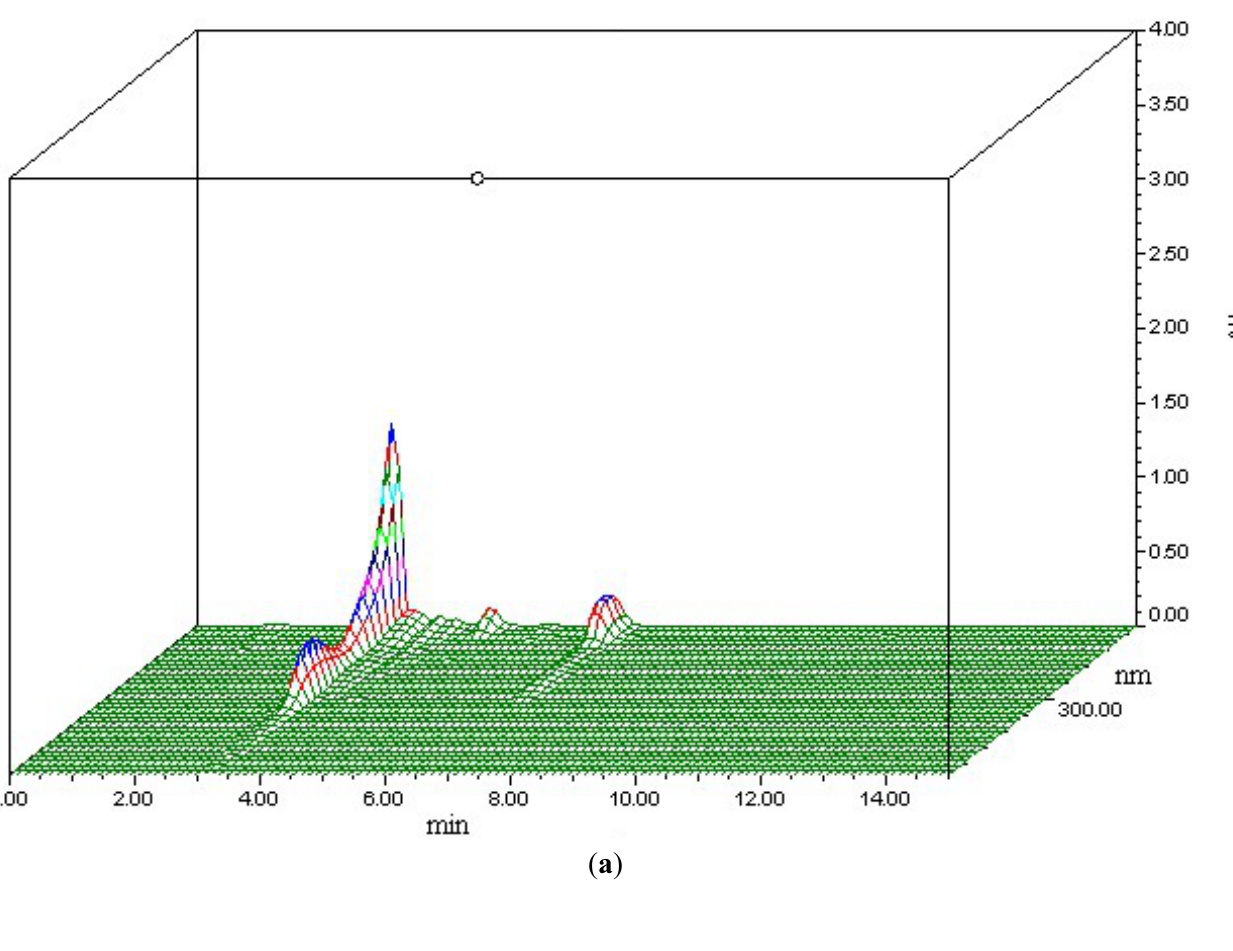
Figure 2. Representative chromatograms of: ( a ) a blank rat plasma sample; ( b ) a blank rat plasma spiked with salidroside and p- tyrosol (20 μ g/mL); ( c ) a rat plasma sample collected 5 min after i.v. administration of salidroside (50 mg/kg); ( d ) a rat plasma sample collected 30 min after i.g. administration of salidroside (100 mg/kg). (1: salidroside, 2: p